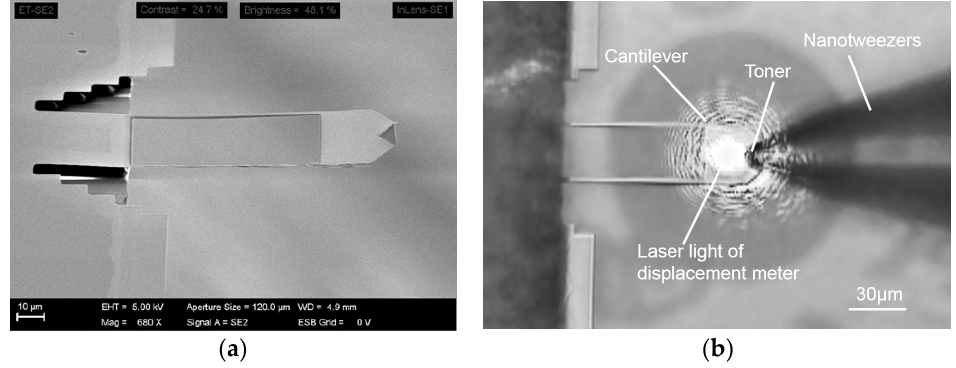
Figure 7. Micrographs of the FIB-processed cantilever: ( a ) Scanning electron microscopy image of the FIB-processed cantilever; ( b ) Optical microscopy image of the FIB-processed cantilever mounted on the piezoelectric stage and nanotweezers gripping the toner particle.